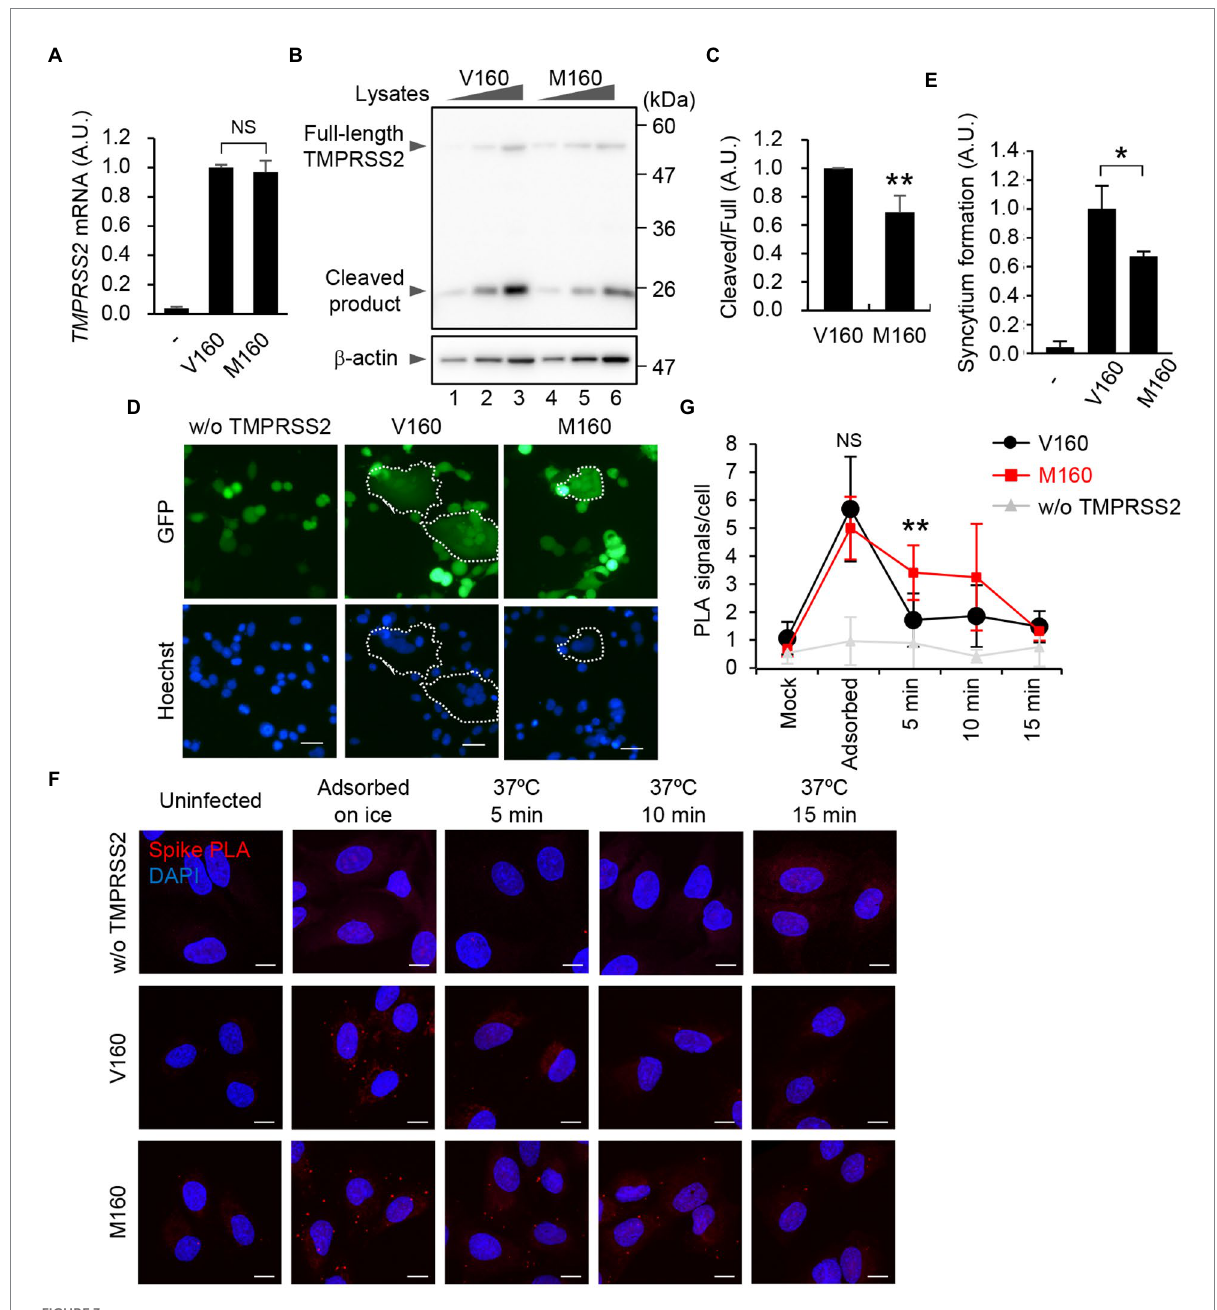
FIGURE 3 V160M substitution of TMPRSS2 delays the viral entry of SARS-CoV-2. (A) Level of TMPRSS2 mRNA. Total RNAs isolated from A549, A549-ACE2- TMPRSS2-V160 (V160), or A549-ACE2-TMPRSS2-M160 (M160) cells were subjected to quantitative RT-PCR with primers specific for TMPRSS2 mRNA. NS; not significant, Student’s t test. Means ± SDs from 3 independent experiments. (B) Expression level of TMPRSS2 protein. The cell lysates obtained from A549-ACE2-TMPRSS2-V160 or M160 cells (5 × 10 3 , 1 × 10 4 , and 2 × 10 4 cells) were analyzed using SDS-PAGE followed by western blot assays with anti-TMPRSS2 and anti- β -actin antibodies. Data are representative of 3 independent experiments. (C) The quantitative data of panel B are shown. ** p < 0.01; 2-tailed Student’s t test. Means ± SDs from 3 independent experiments. (D) HEK293T cells transfected with plasmids expressing spike and GFP (1 × 10 4 cells) were co-cultured with A549-ACE2-TMPRSS2-V160 or M160 cells (1 × 10 5 cells). At 24 h post-transfection, the cells were fixed in 2% PFA and stained with Hoechst33342 (Blue). The dotted circle encloses the syncytia. Scale bar, 40 μ m. Data are representatives of 3 independent experiments. (E) The quantitative data of panel D are shown with means ± SDs. The number of syncytia was counted and normalized with total GFP-positive cells ( N > 400). * p < 0.05, ** p < 0.01; 2-tailed Student’s t -test. (F) A549, A549-ACE2-TMPRSS2-V160 or M160 cells were infected with SARS-CoV-2 at an MOI of 100 on ice for 30 min. The cells were further incubated at 37 ° C for 5, 10, and 15 min. After fixation, the cells were subjected to single-recognition in situ PLA with anti-Spike antibody. Scale bar, 10 μ m. Data are representative of 3 independent experiments. (G) The number of PLA signals per cells is shown with means ± SDs ( n > 30). NS; not significant, ** p < 0.01; 1-way ANOVA with the Tukey